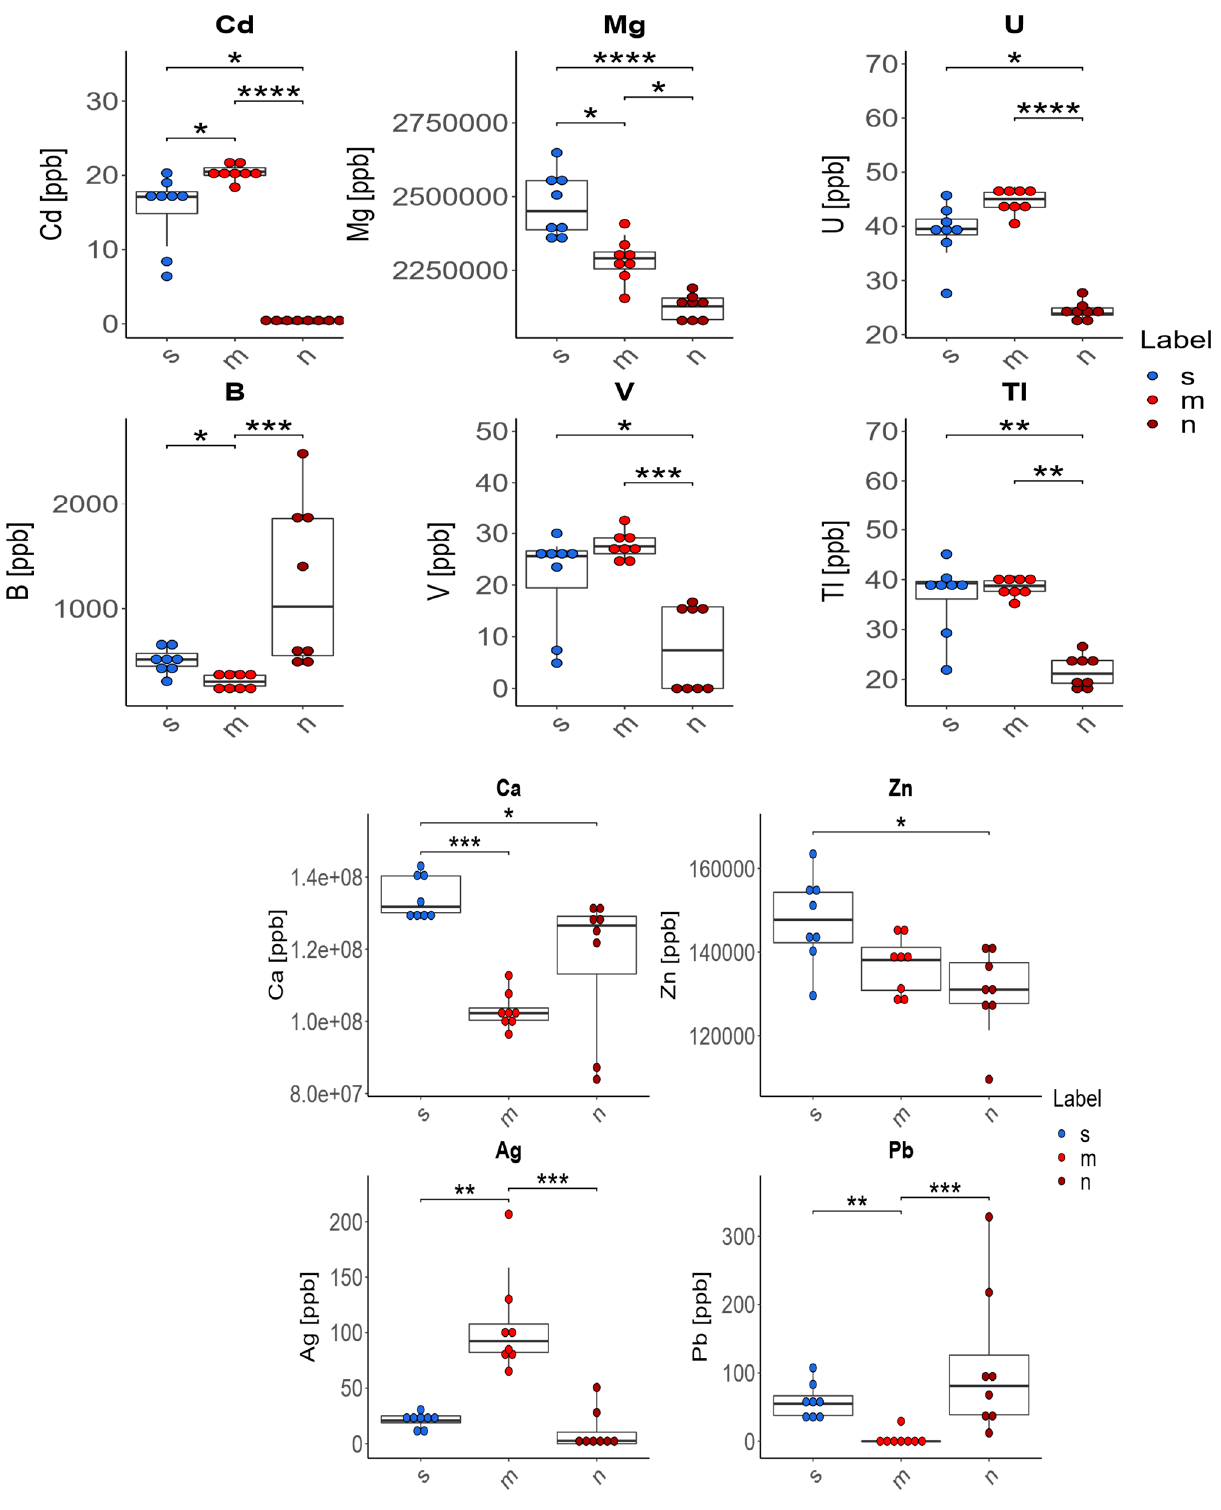
Figure 1. Analysis of concentrations of elements in three experimental groups: s—standard group (blue boxplot); m—group receiving zinc in microparticles (red boxplot); n—group receiving zinc in nanoparticles (dark red boxplot); p -value: <0.0001 ****, 0.0001–0.001 ***, 0.001–0.01 **, 0.01–0.05 *. There were no statistically signi fi cant di ff erences in the levels of As, Ba, Cr, Cu, Fe, K, Mn, Na, Ni, Rb, Se, or Sr in the bones of rats depending on the supplementation used.